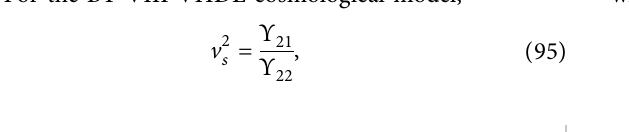
− ω ) for BT-VIII. vhde vhde ′